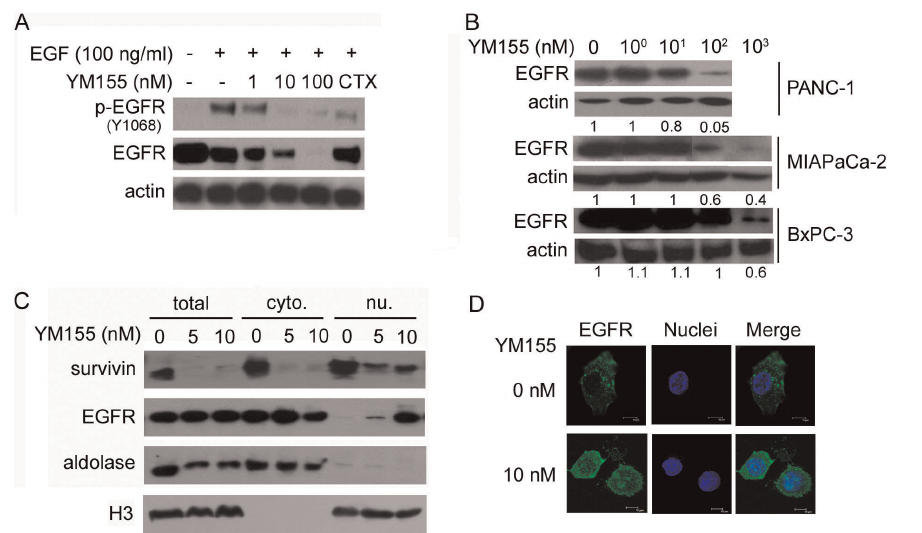
Figure 3. YM155 downregulates EGFR in pancreatic cancer cell lines. A, PANC-1 cells were stimulated with 100 ng/ml EGF for 10 minutes before incubating with or without YM155 for 6 hours. Cetuximab (CTX; 100 ng/ml for 1 hour) was used as a control. Levels of phosphorylated (Y1068) EGFR and total EGFR were analyzed by Western blotting. B, YM155 diminished the expression of EGFR in a concentration-dependent manner in PANC-1, MIAPaCa-2 (cropped blots; full-length blots are presented in Fig. S5A), and BxPC-3 cells. The ratio of EGFR:actin expression compared with the control is shown for each lane (using Multi-Gauge v2.3 software). C, Survivin and EGFR expression were detected in subcellular fractions of PANC- 1 cells by Western blotting. Cytoplasmic (cyto) and nuclear (nu) fractions were isolated after exposure to YM155 for 24 hours. Aldolase (cytoplasmic) and H3 (nuclear) served as markers for the purity of subcellular fractions. Total lysates (total) were analyzed concurrently. D, YM155 (10 nM) induced the nuclear EGFR accumulation. PANC-1 cells were stained with anti-EGFR, anti-Alexa Fluor 488, and DAPI after the YM155 treatment. Scale